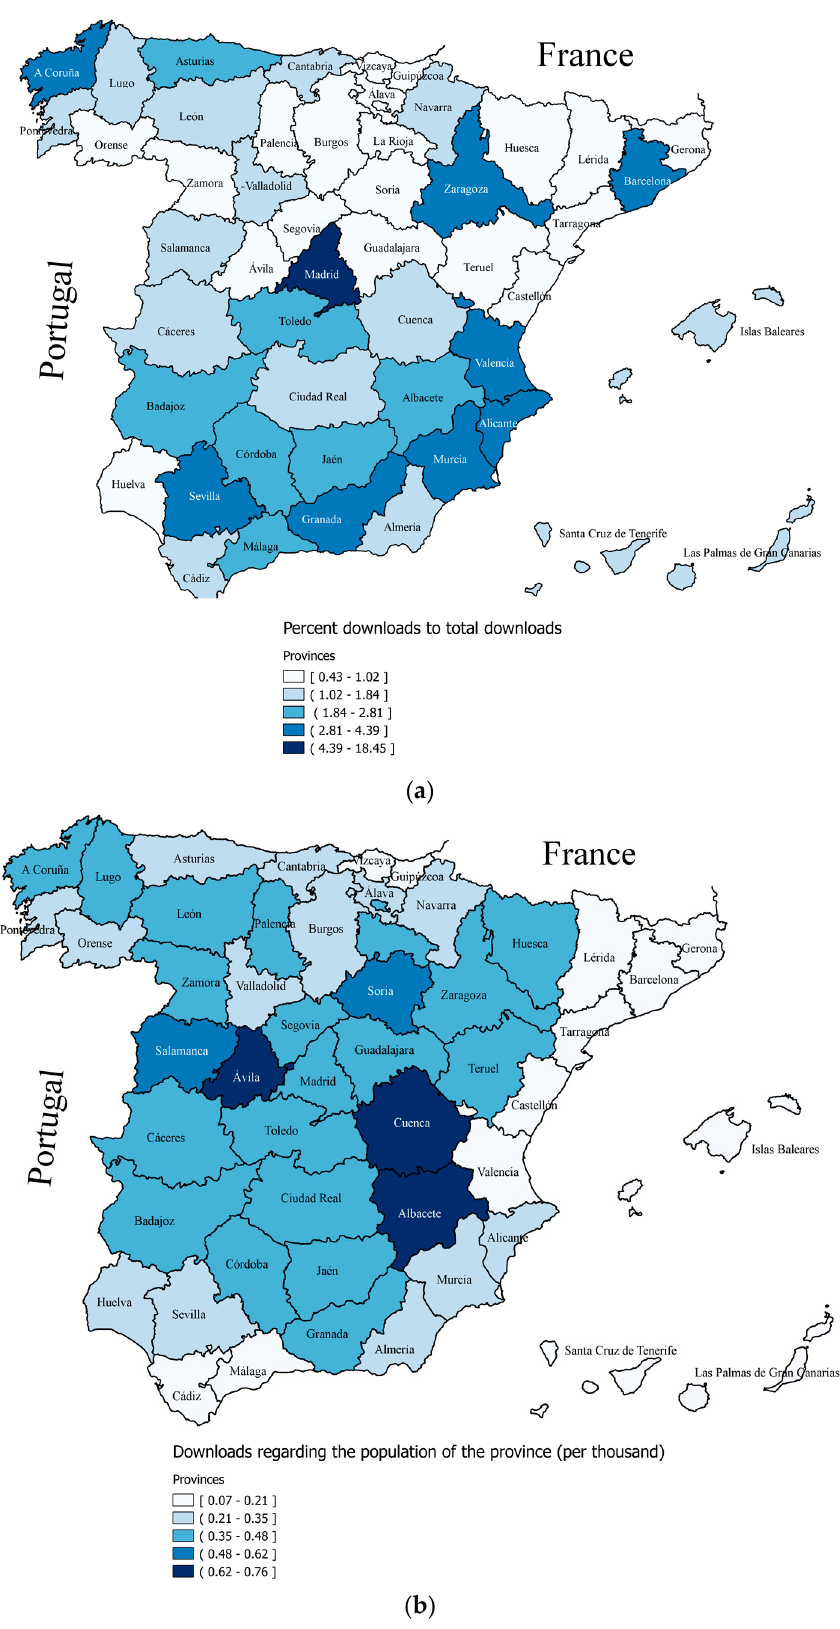
Figure 2. Distribution by province of downloads in Spain: ( a ) percentage of the total downloads, ( b ) number of downloads per thousand inhabitants (relates downloads with the population of each province).